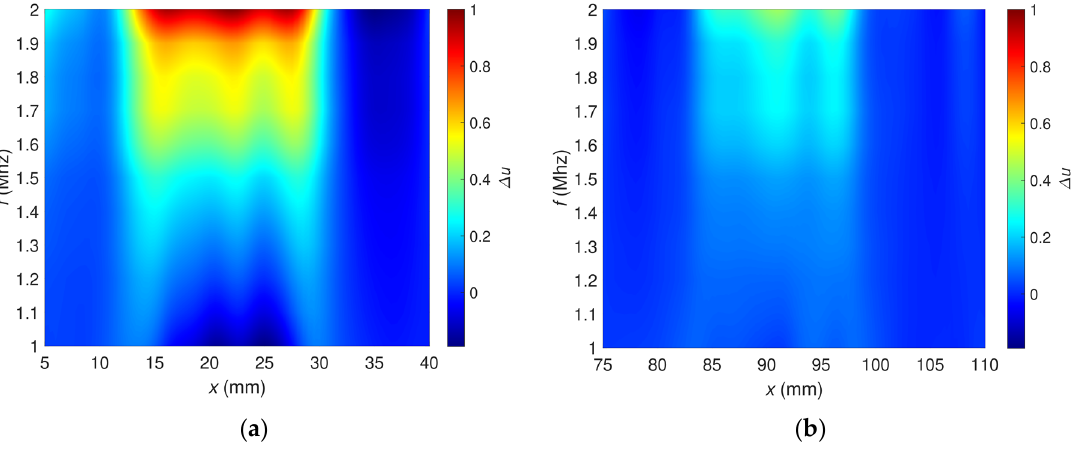
Figure 7. Spectrograms of relative voltage ( a ) OF70%, ( b ) OF30%.